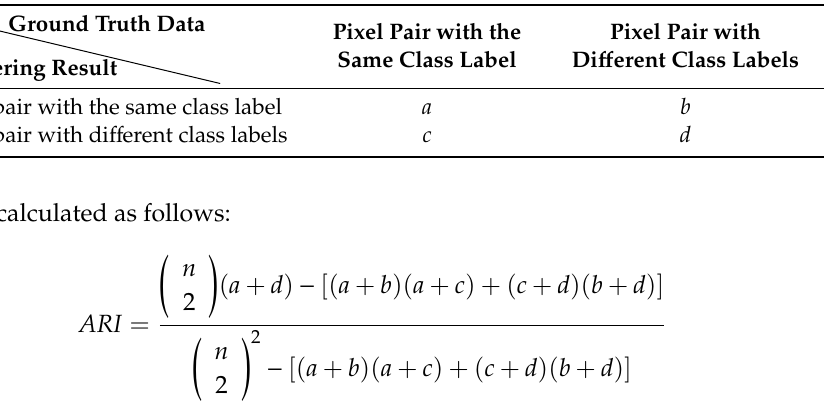
Table 4. Contingency Table of the Clustering Result and Ground Truth